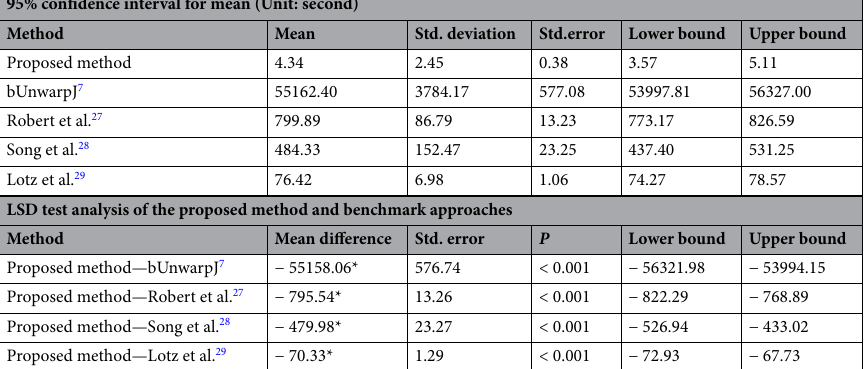
95% confidence interval for mean (Unit: